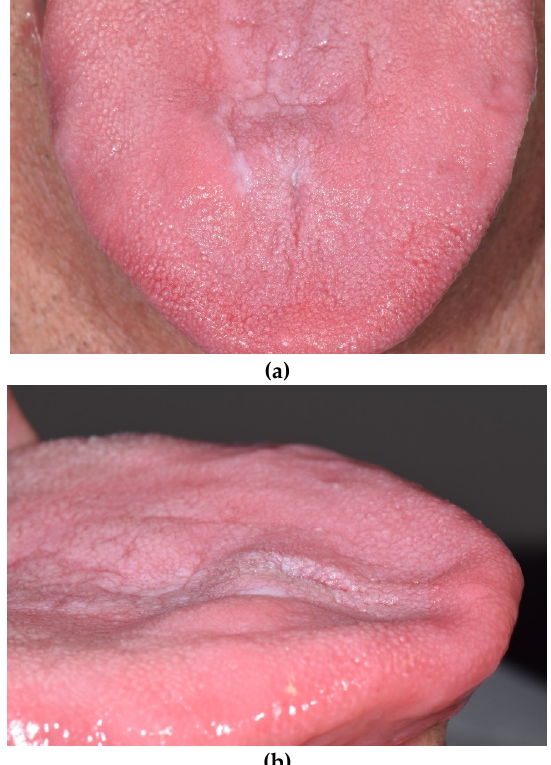
Figure 1. Tongue nodular lesion, as observed at first examination: the localized swelling on the lingual dorsum was covered by normal mucosa. ( a ) Frontal view of the lesion, ( b ) lateral view of the lesion.